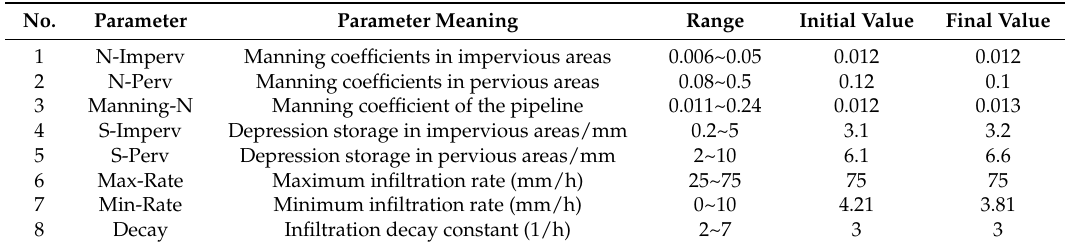
Figure 3. Flow chart of the calibration. Table 1. Calibration results of parameters in